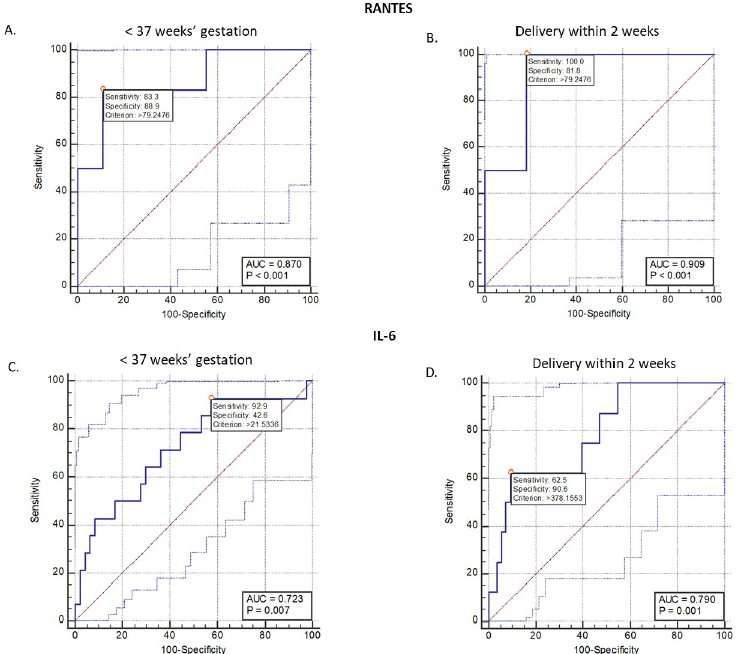
Fig 4. Receiver operating characteristic curve analysis of cervicovaginal fluid RANTES (A-B) and IL-6 (C-D) in predicting preterm delivery and delivery within 2 weeks of presentation with symptoms of preterm labour. AUC , area under the ROC